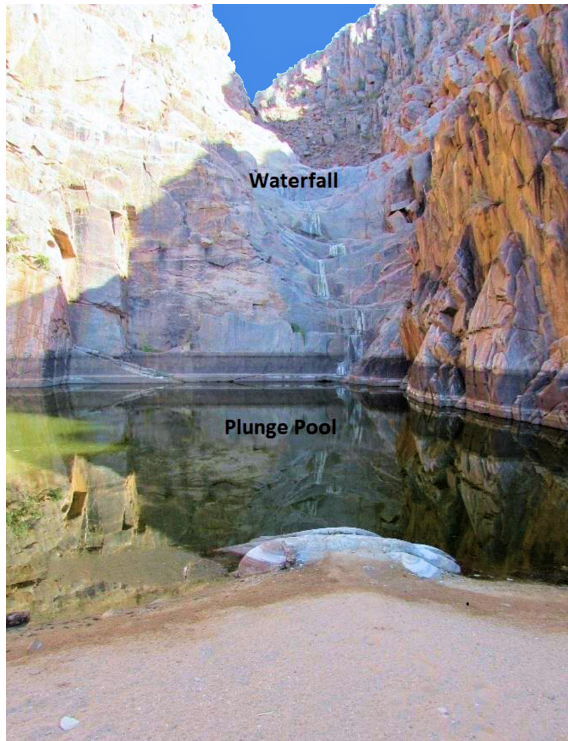
Fig. 7. A dry waterfall developed in Neoproterozoic metaquartzites at Etusis, central Namibia, with a water-filled plunge pool at its base. The mean annual rainfall at this site is only c. 240 mm per year.